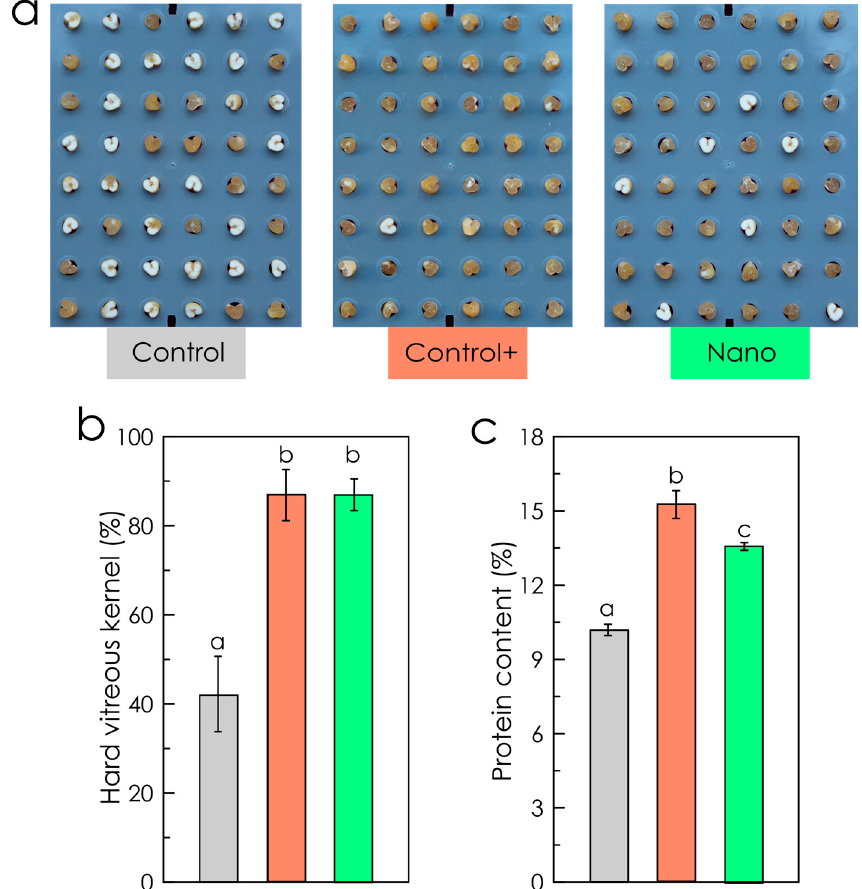
Figure 5. Quality parameters of durum wheat. Vitreousness of 48 split kernels ( a ). Percentage of hard vitreous kernel ( b ) and protein content ( c ) for the three treatments. Data are expressed as average with the corresponding standard error as bars ( n = 3). Different letters indicate significant differences between the treatments ( p ≤ 0.05).